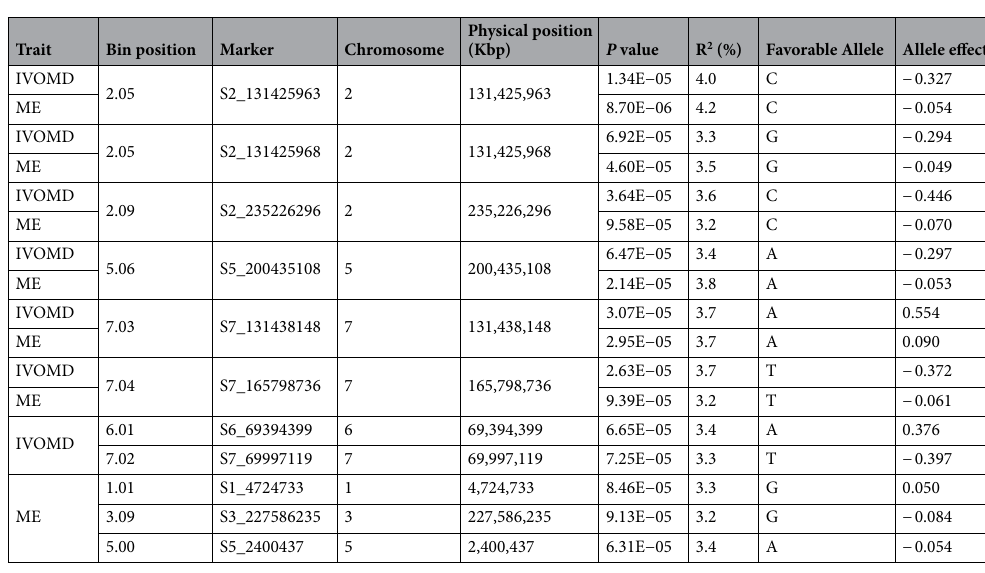
Table 2. Top SNPs associated with in vitro organic matter digestibility (IVOMD) and metabolizable energy (ME).